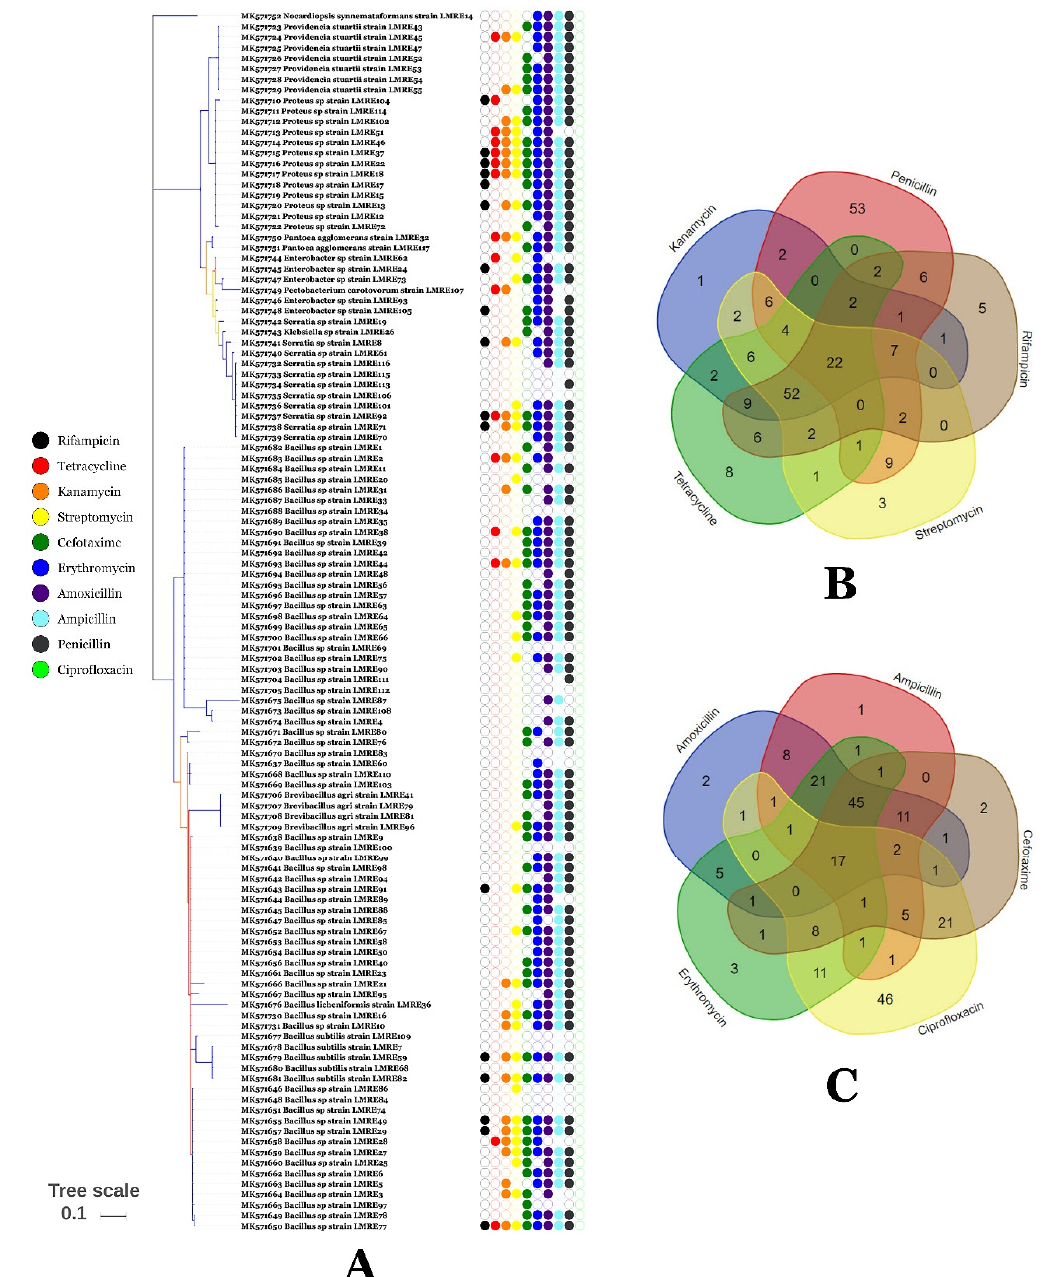
Figure 8. ( A ) Shape-plot and ( B ) Venn diagram of antibiotic resistance of Gram-positive and Gram-negative bacterial isolates.